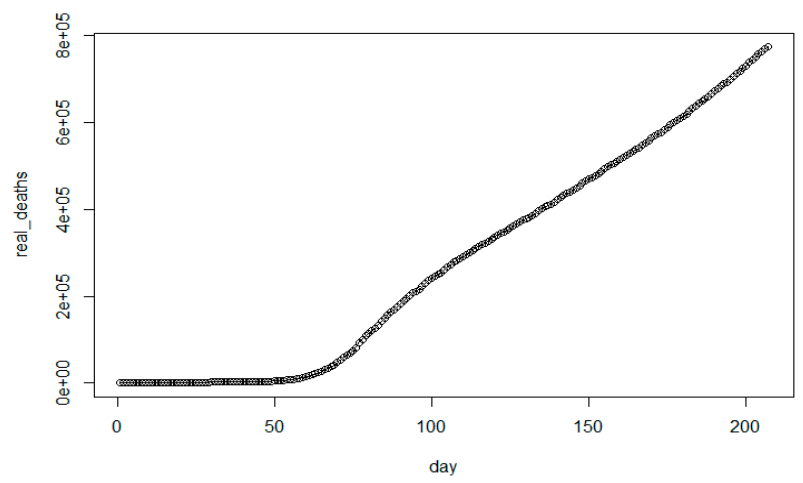
Figure 6. Worldwide cumulative number of deaths over time.